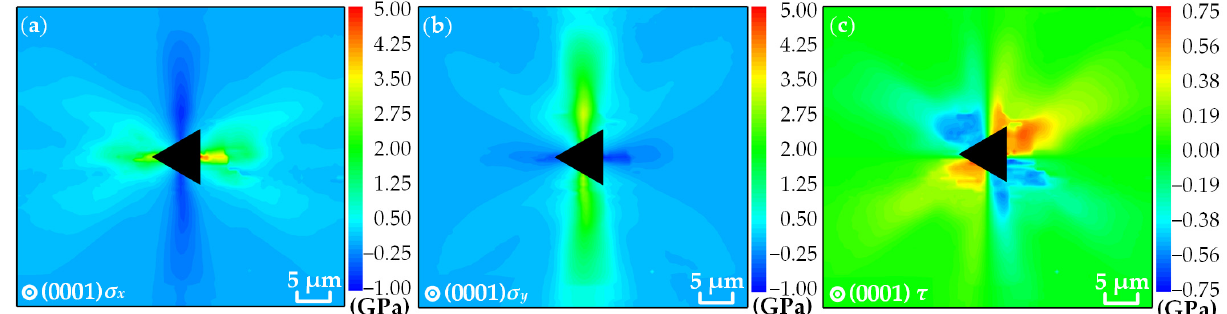
Figure 10. Distributions of ( a ) normal stress σ x , ( b ) normal stress σ y and ( c ) shear stress τ .